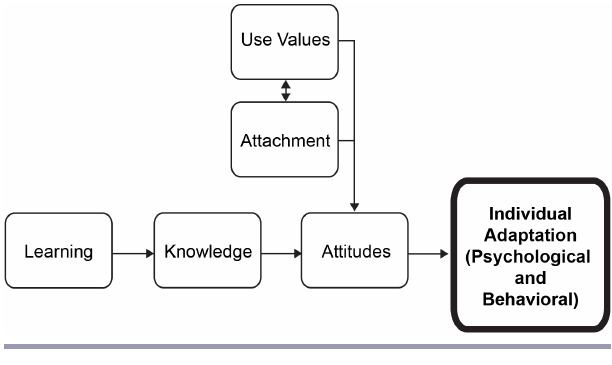
Fig. 3 . Cognitive, affective, and evaluative factors that interact to affect behavioral and psychological adaptations at the individual actor